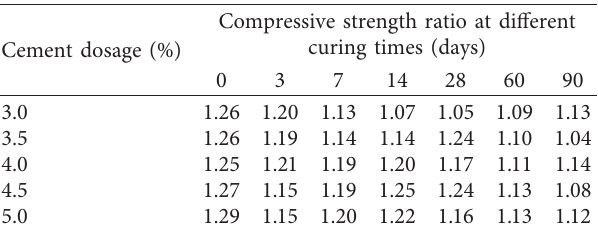
Table 9: Ratios of compressive strengths of the CSCG in the case of GM and XM gradations.